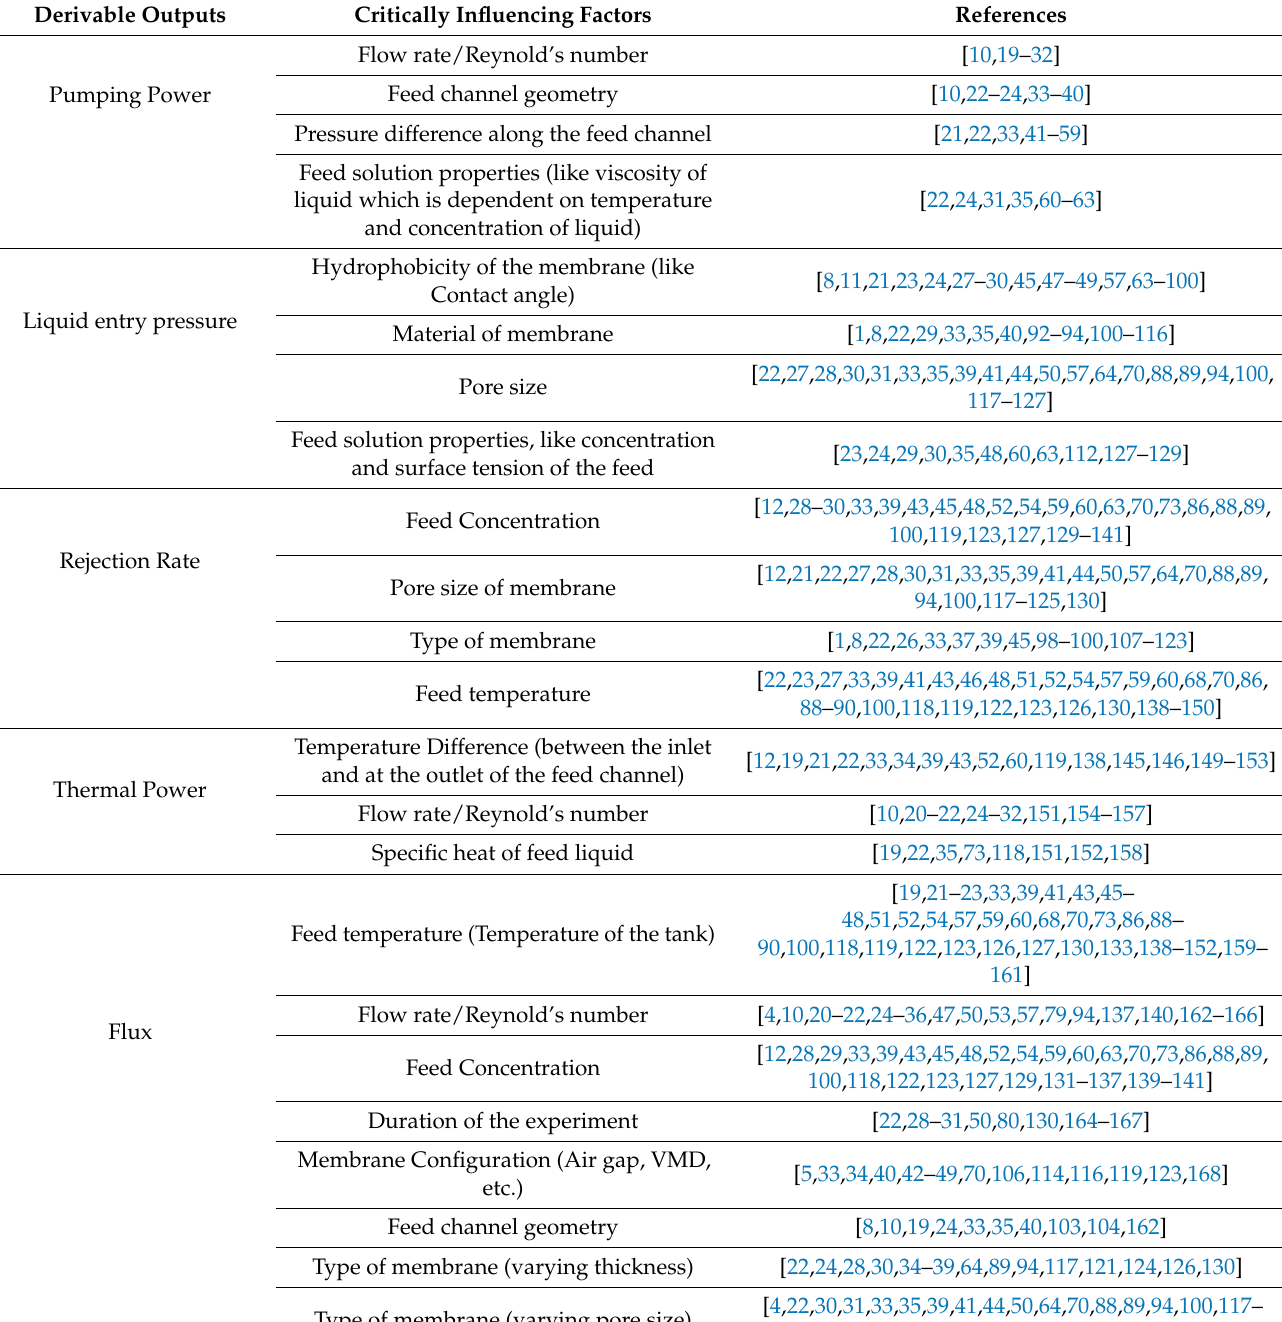
Table 1. Derivable output and critical influencing factor (CIF) of